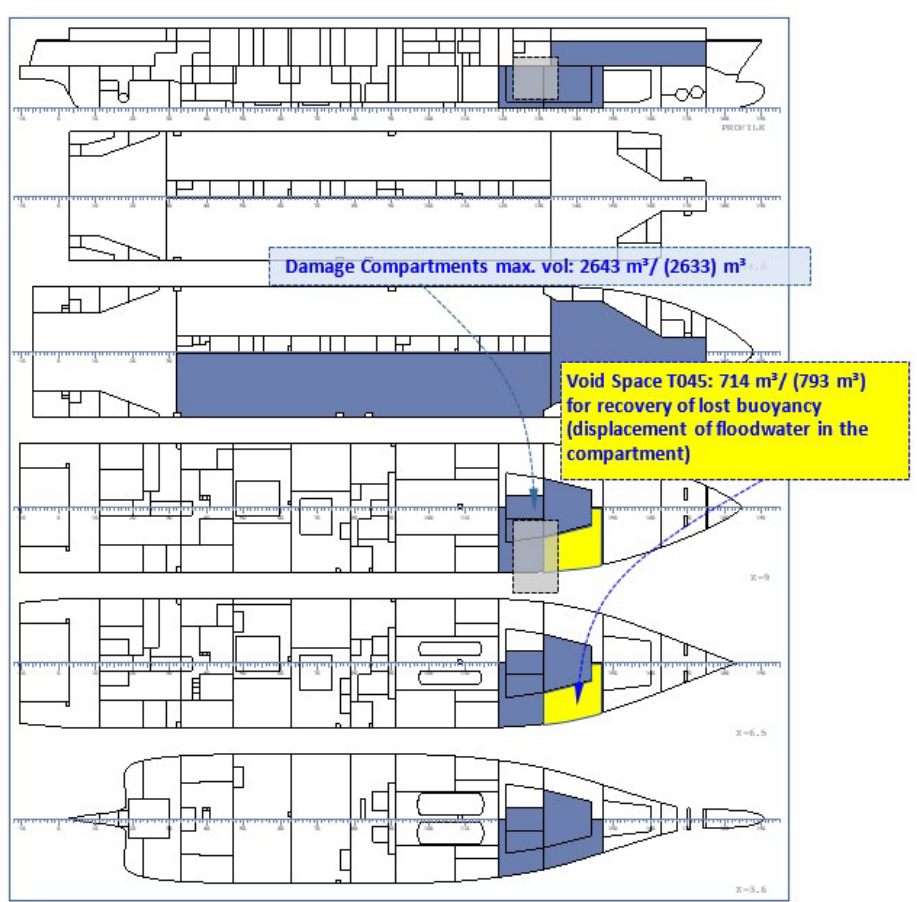
Figure 11. Damage Case 4 with recovery of lost buoyancy: The grey rectangle shows the damage penetration. The damaged compartments T001, T043, T046, T083, T098, and T045 are shown with dark blue-grey or yellow, the T045 with yellow being the compartment for recovery of lost buoyancy through floodwater displacement. The first water volume values are those in the numerical model, the values in brackets are the values realized in the scale model used in the model tests.